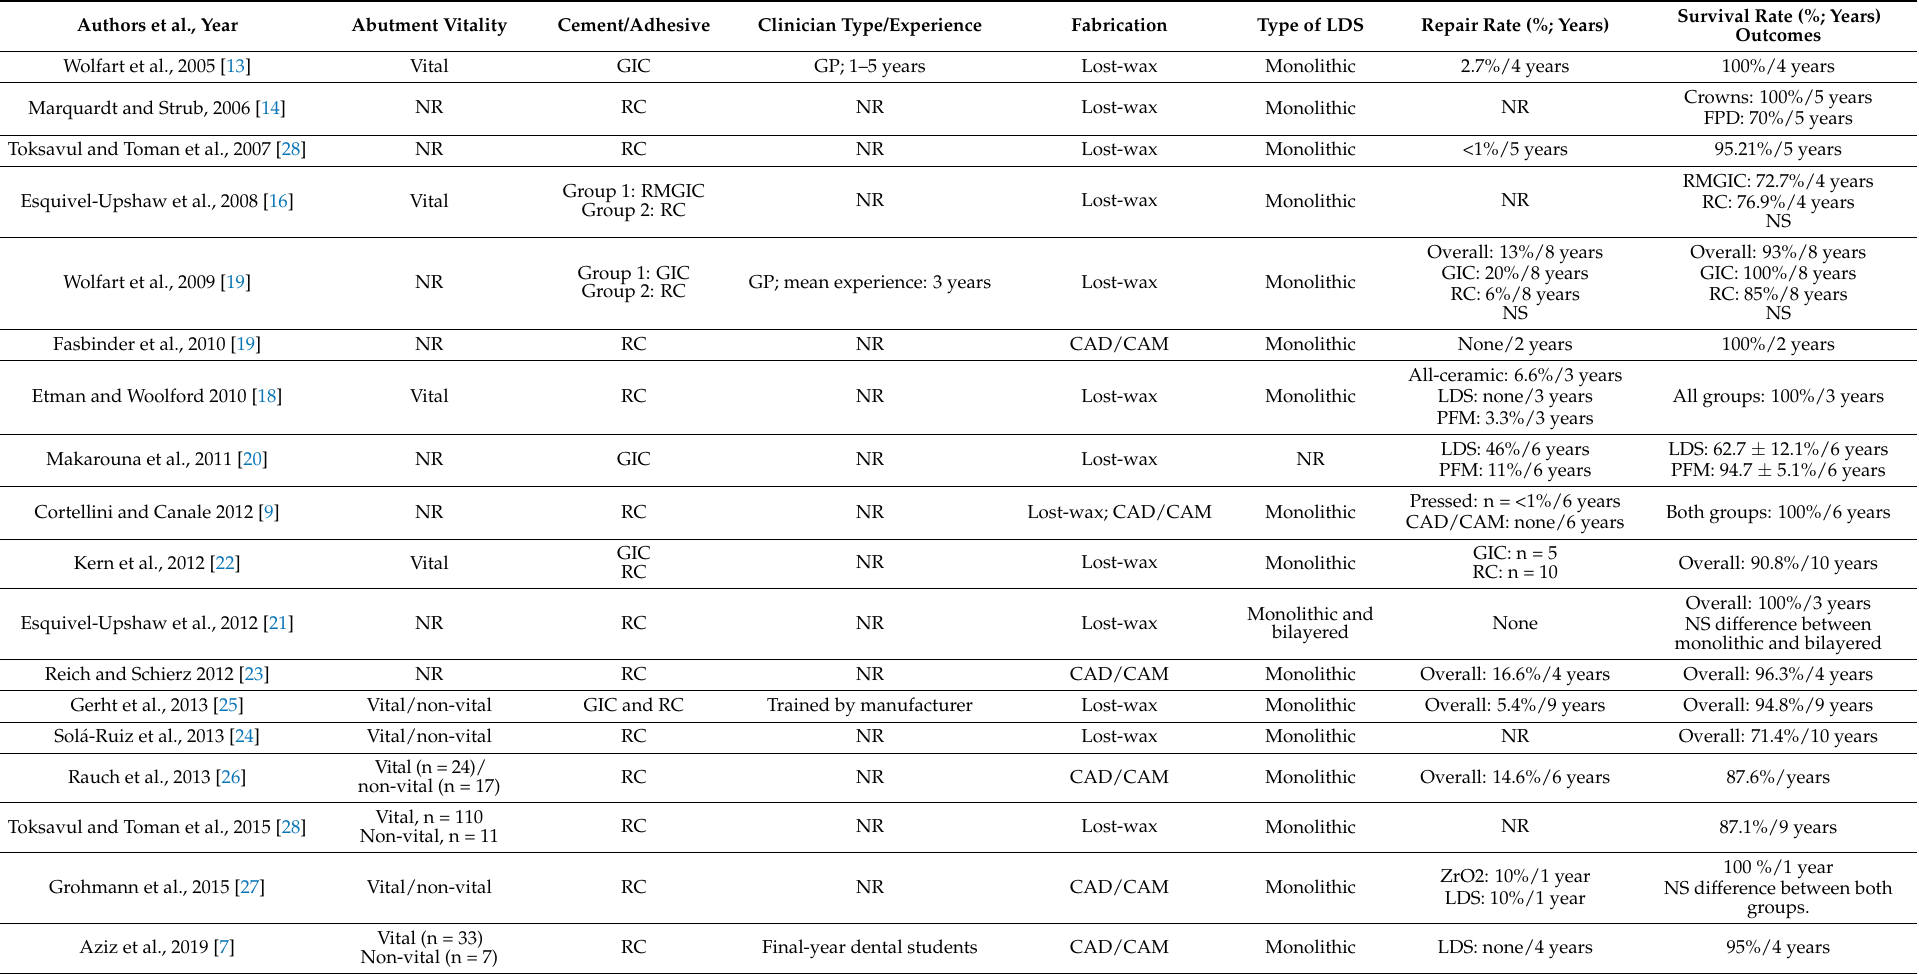
Table 2. Other characteristics, survival rates, and outcomes of the included